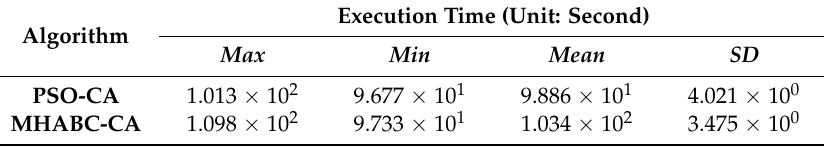
Table 6. Execution performance comparison of MHABC-CA algorithm and particle swarm optimization (PSO)-CA